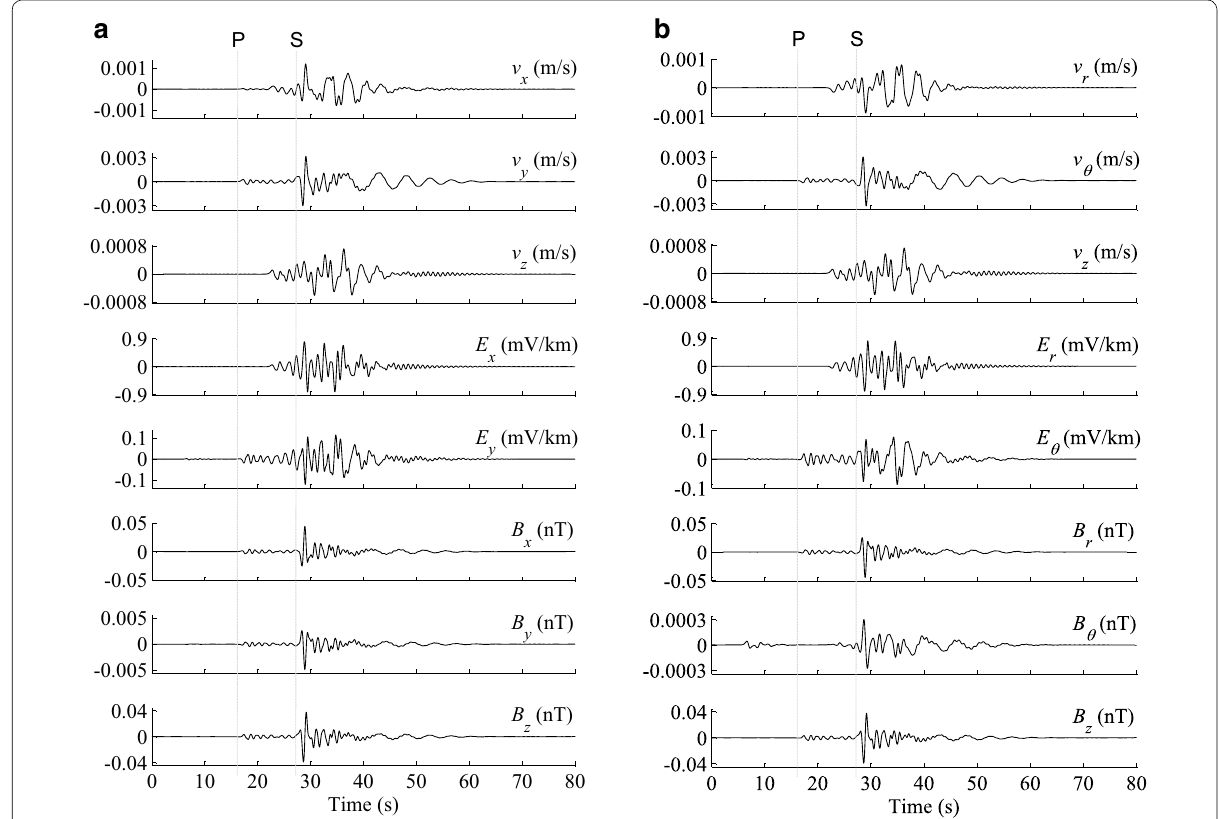
Fig. 10 Additional seismic and EM wave‑fields resulting from the artificial scattering effect. We consider the seven‑layer half‑space model, the receiver located at ( 80,890, 8680, 0.1) m and an artificial scattering effect with an artificial scattering conversion coefficient of C st − the wave‑fields before applying the horizontal wave‑field rotation. They are caused by PSV‑to‑SH and SH‑to‑PSV